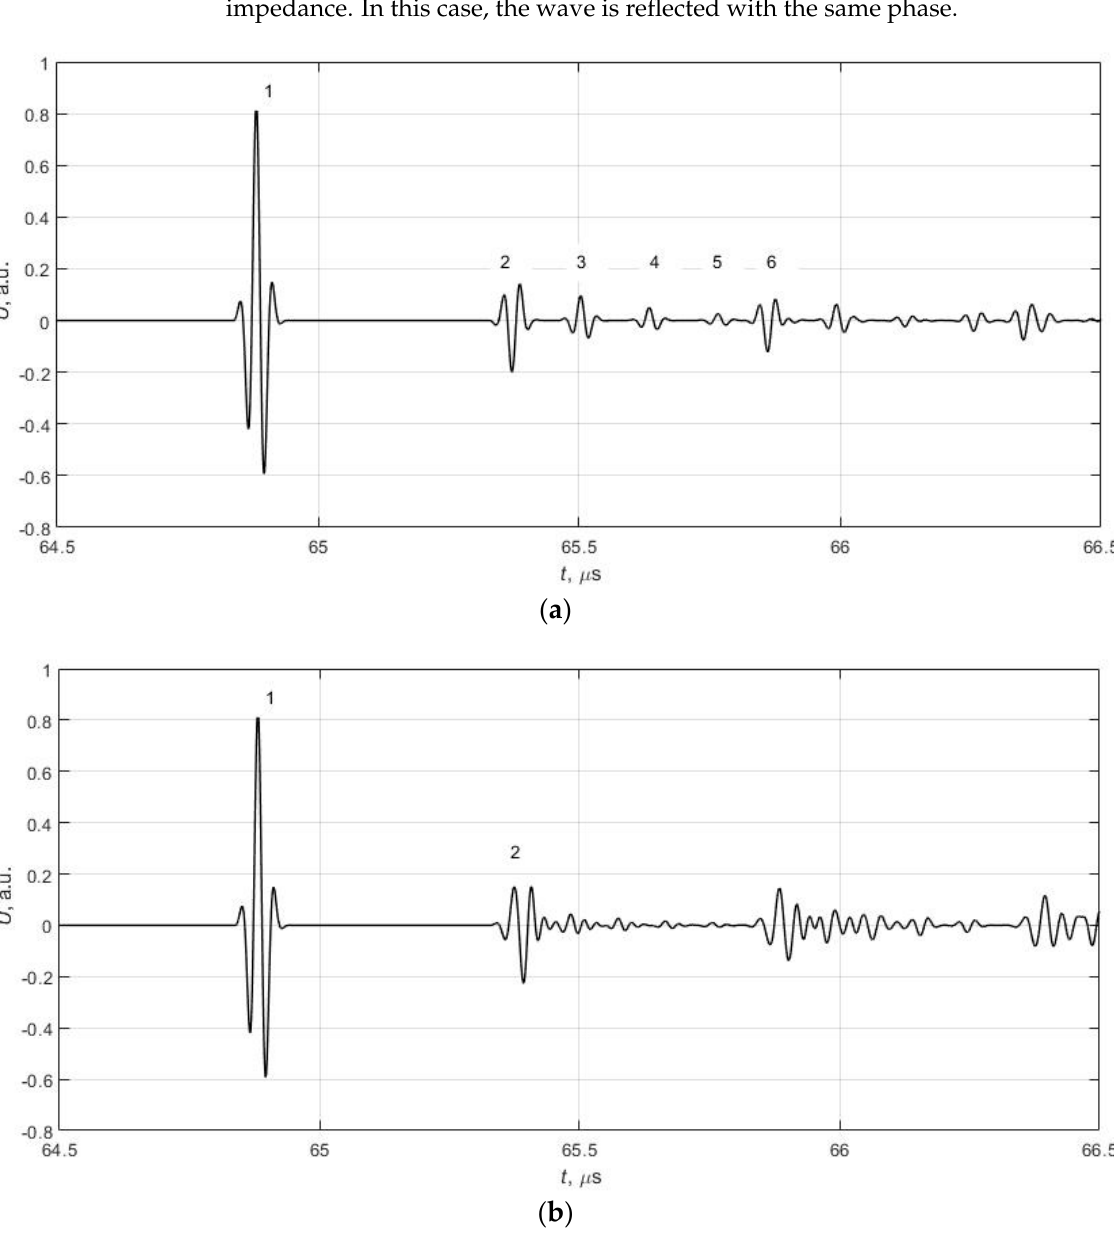
Figure 7. Impulses characterizing each signal reflection from the boundaries of the sample: ( a ) without defect, ( b ) with defect.